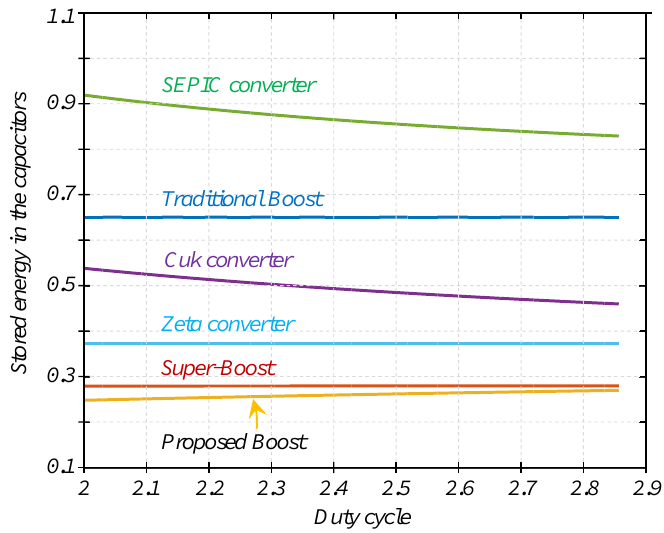
Figure 20. Stored energy in capacitors for all topologies in the full operation range vs. the converter gain G.